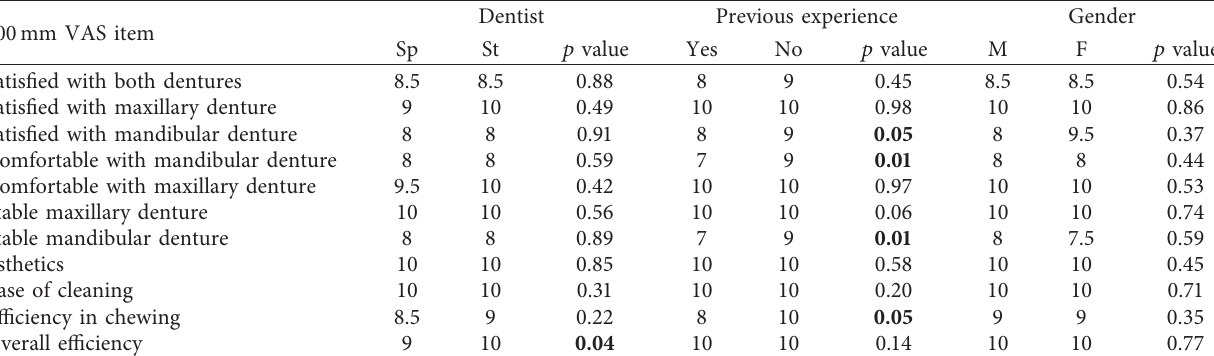
Table 3: Results of the median and statistical analysis for the different questions included in the 100mm VAS part of the questionnaire for the factors dentist, previous experience, and gender.